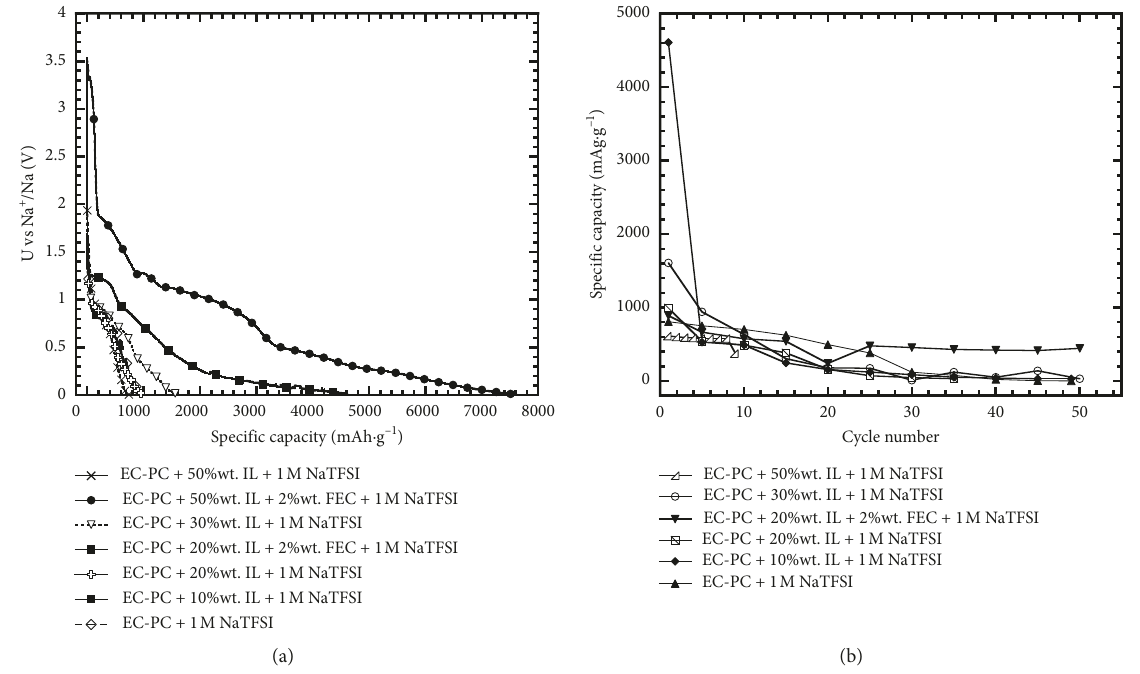
Figure 5: (a) 1 st discharge curve of half-cell ( − ) Na | EC-PC (1:1)+ x wt.% EMI-TFSI+1M NaTFSI | SnS/C and (b) cycling discharge capacity as a function of cycle number at C/10 rate.